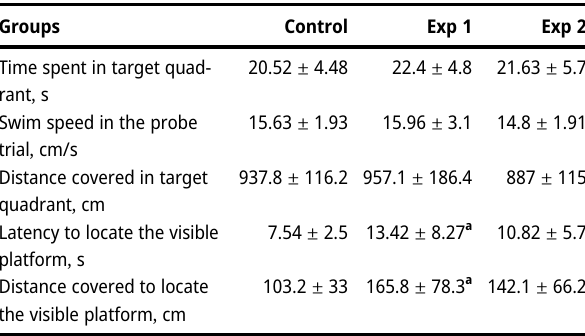
Table  : Intergroup comparison of probe and visible test parameters in Morris water maze.